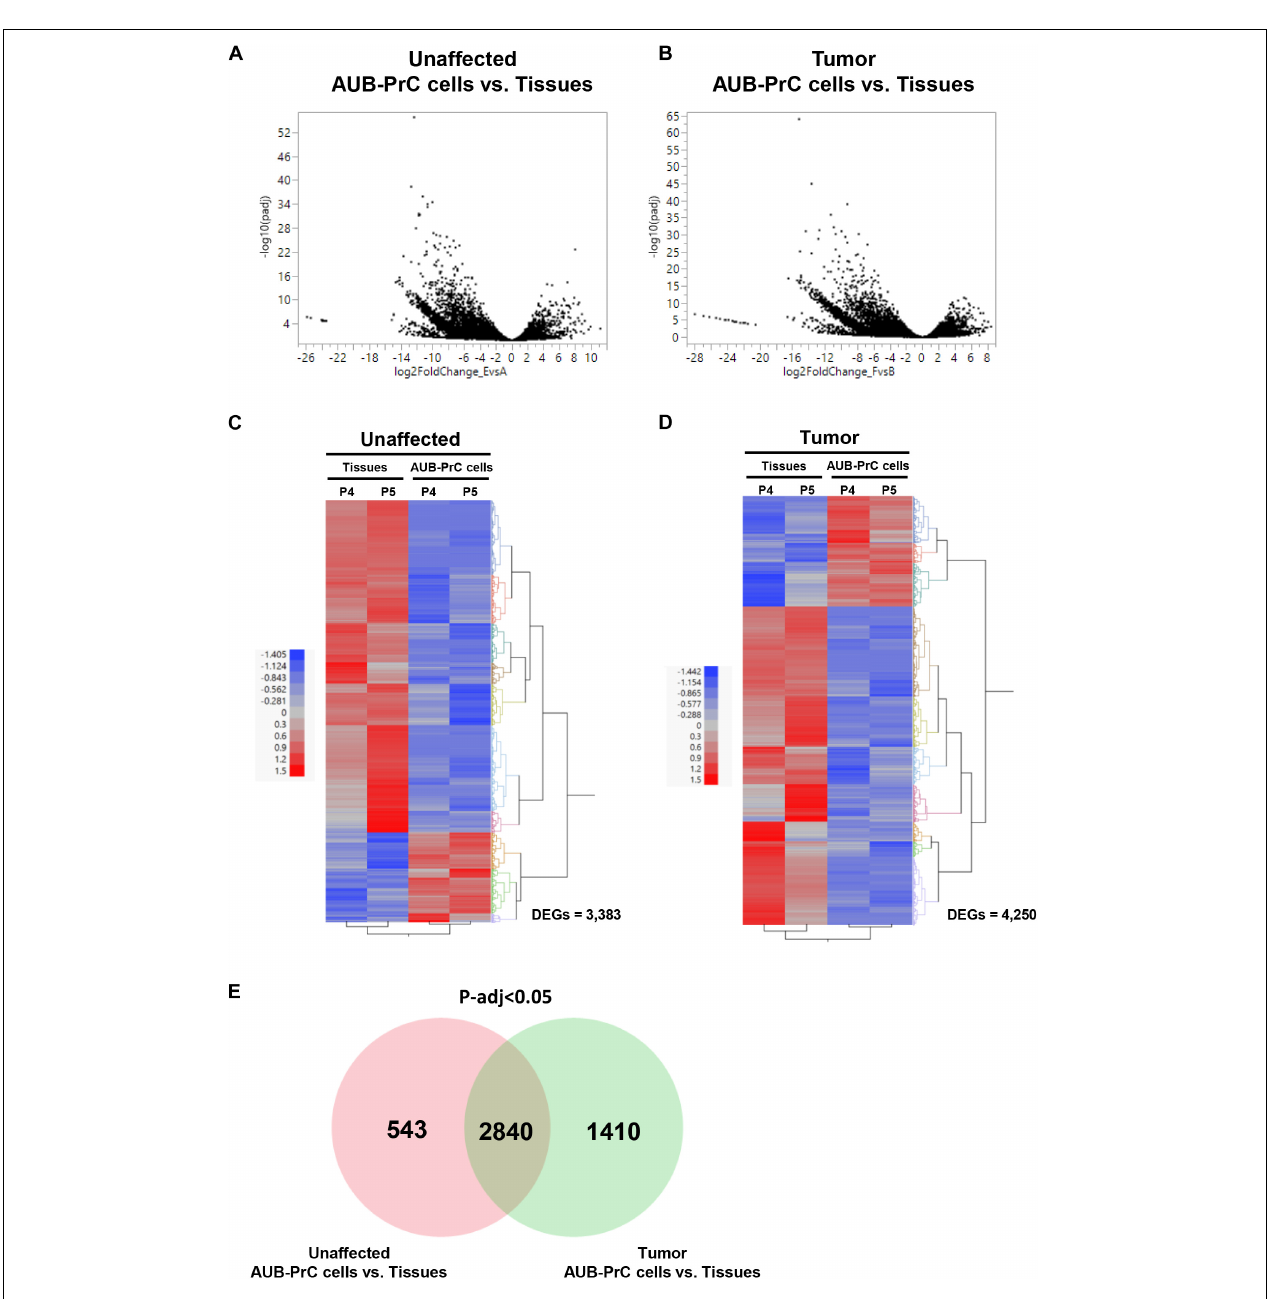
FIGURE 4 | RNA-sequencing of patient-derived AUB-PrC cells relative to their corresponding tissues in unaffected and tumor samples. RNA-Seq was performed using the Hi-Seq 2500 Illumina platform to delineate the differentially expressed genes (DEG) as described in “Materials and Methods” section. Volcano plots (A,B) and Venn diagram (E) demonstrating an overview of the DEGs. The threshold was set at p -adjusted < 0.05. Differentially expressed transcripts ( n = 3,383 and 4,250 in unaffected and tumor samples) between AUB-PrC cells and tissue counterparts {two biological replicates and two technical duplicates in each group; patient 4 with Grade Group 1 [Gleason Score 6(3 + 3)] and patient 5 with Grade Group 3 [Gleason Score 7(4 + 3)]; patients characteristics in Supplementary Table S1 } were identified using statistical criteria detailed in “Materials and Methods” section. (C,D) Heatmaps and the hierarchical cluster analyses of the differentially expressed genes for unaffected (C) and tumor (D) samples. Red represents the upregulated genes and blue represents the downregulated genes.